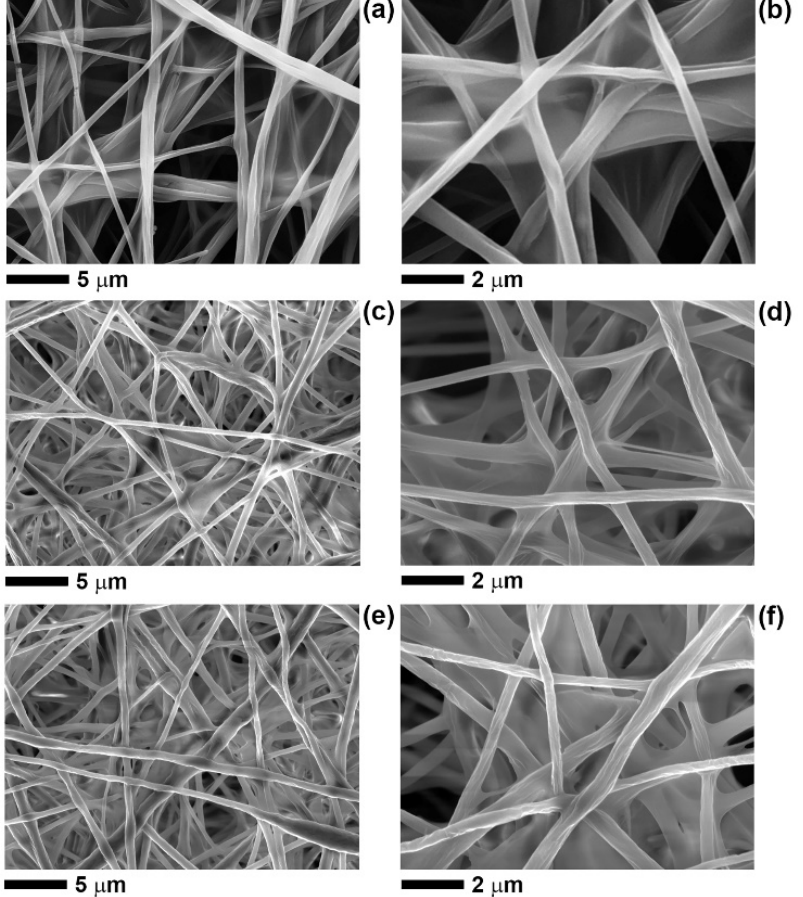
Figure 2. SEM micrographs, at different magnification, of CS-coated fibres: ( a , b ) cPLA, ( c , d ) cPLA-BP, ( e , f ) cPLA-limonene.